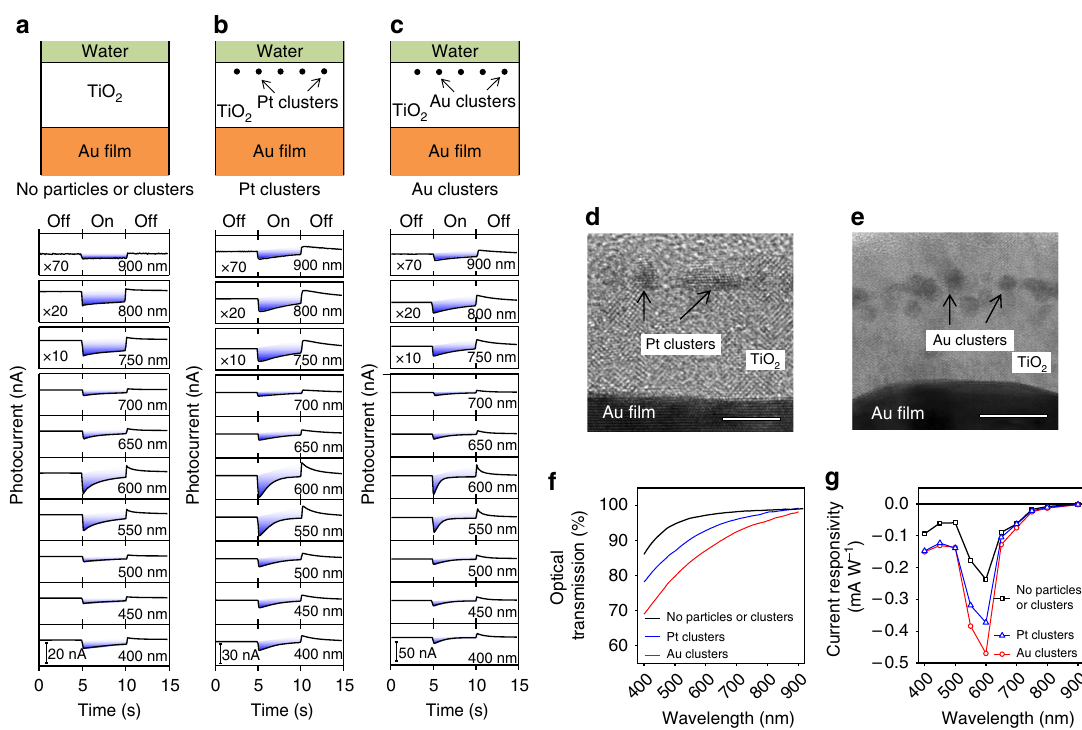
Fig. 4 Absence of the hot-electron interplay effect without Au nanoparticles (AuNPs). a Schematic of the device in the absence of AuNPs and results of the photocurrent measurements. b Schematic of the device in which Pt clusters are embedded in place of AuNPs and results of the photocurrent measurements. c Schematic of the device in which Au clusters are embedded in place of AuNPs and results of the photocurrent measurements. d , e Transmission electron microscope (TEM) measurements of the Pt clusters and Au clusters. Scale bars : 5 and 10 nm, respectively. f Optical transmission through the devices in the absence of the Au fi lm. g Photocurrent responsivities of the devices presented in a , b , and fi lm/TiO 2 in the absence of the AuNPs (Fig. 4a); device 2: FTO/ Au fi lm/TiO 2 /Pt clusters/TiO 2 (Fig. 4b); device 3: FTO/Au fi lm/ TiO 2 /Au clusters/TiO 2 (Fig. 4c). The Pt and Au clusters are